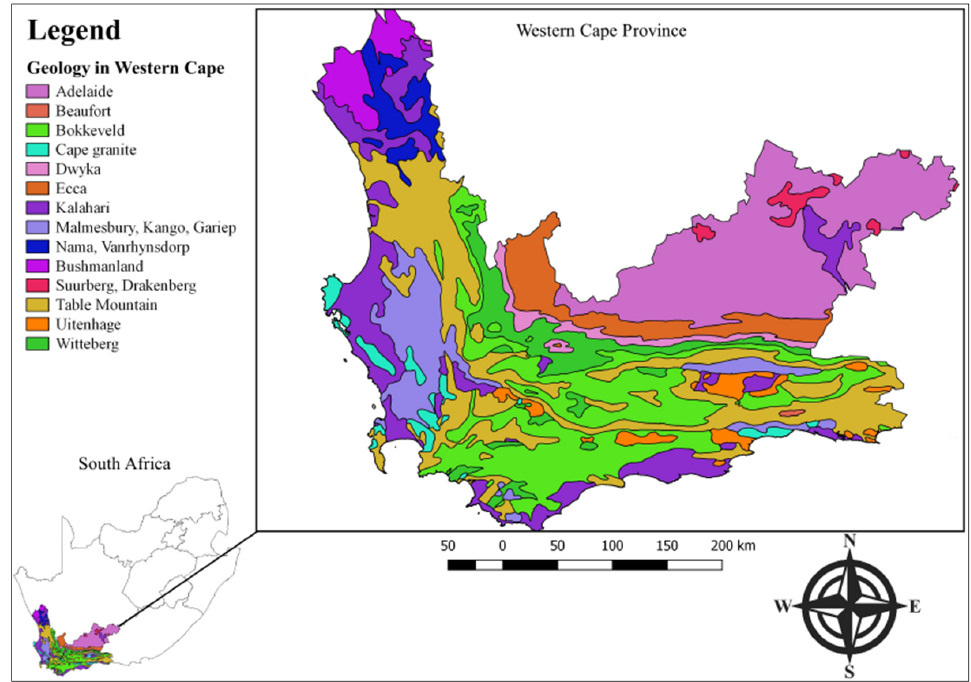
Figure 1. Map of South Africa showing the Western Cape province’s